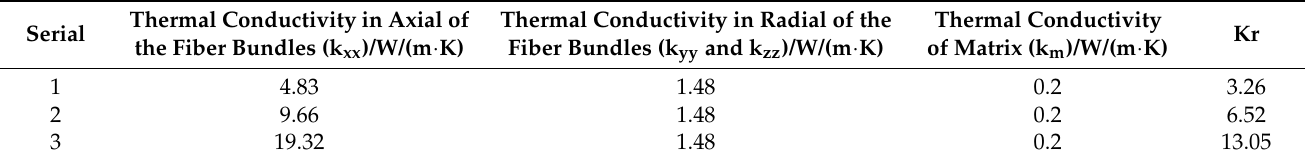
Table 1. Thermal conductivities of the